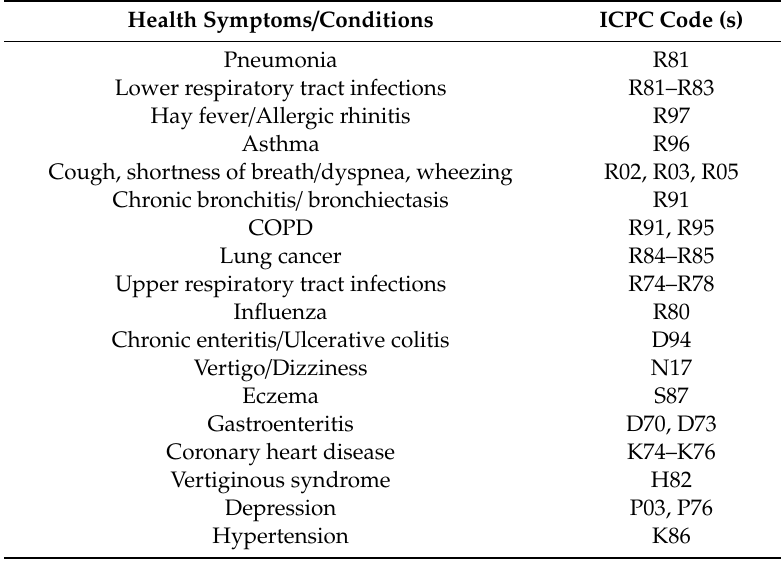
Table A3. Overview of the included health outcomes with the corresponding registration codes in primary